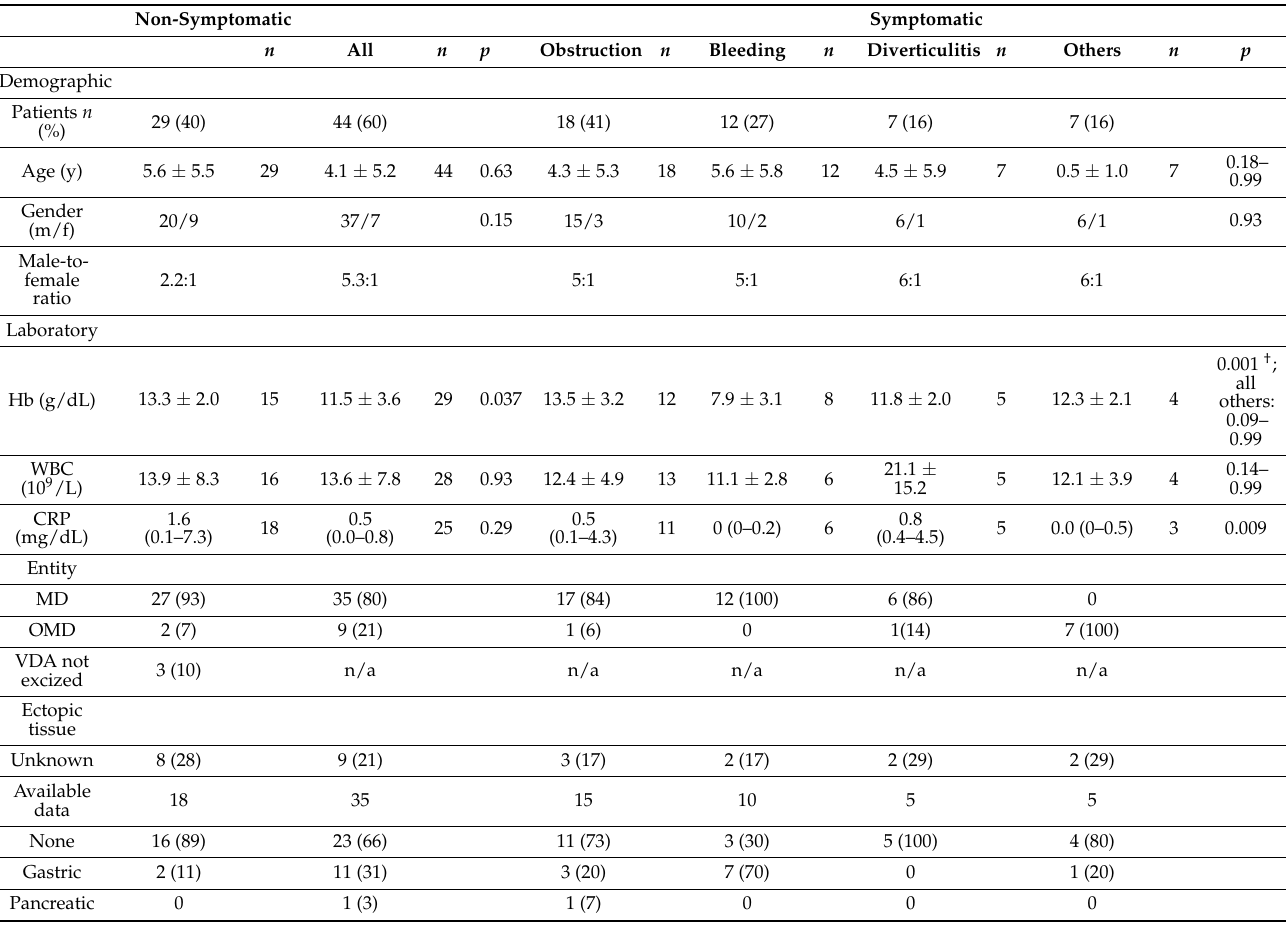
Table 2. Characteristics of asymptomatic and symptomatic vitelline duct anomalies and Meckel’s